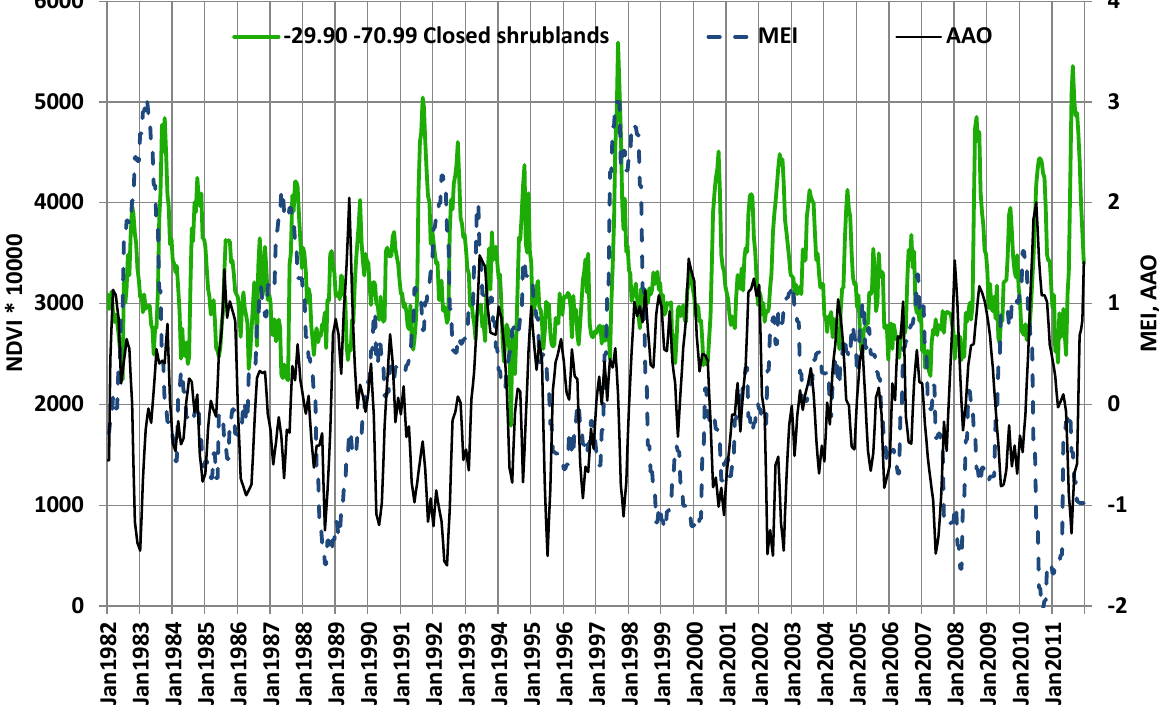
Figure 10. The AAO data tends to be more variable than the MEI data. We therefor plotted a 3-month moving average of the AAO data with the monthly MEI and the NDVI data. The latitude and longitude for this closed shrubland sample are indicated in the